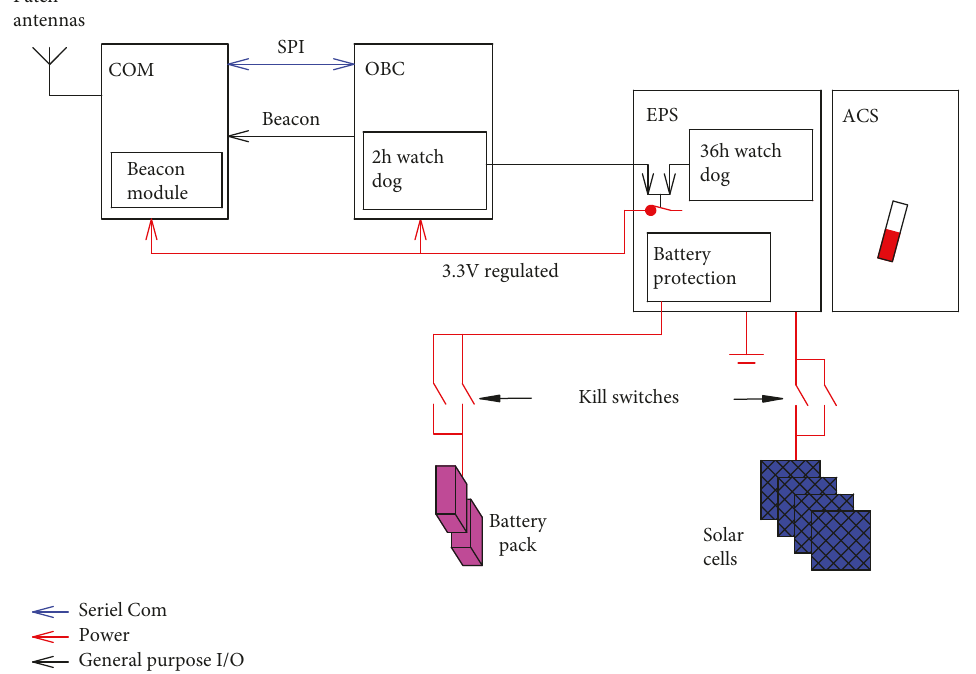
Figure 3: Schematics of the EPS system. Once the kill switches are deactivated at deployment, the EPS, COM, and OBC systems are powered. Two watch dog timers have been implemented, one in the OBC SW with a 2 h period and one in the EPS with a 36 h period. Beacons are generated by the OBC and the COM systems separately; the systems take turns in transmitting their